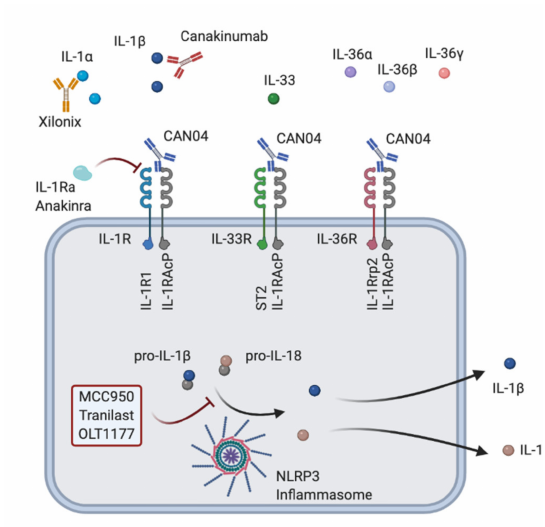
Figure 2. Different treatment strategies to modulate the IL-1–IL-1R pathway. Xilonix, anti-IL-1 α antibody; canakinumab, anti-IL-1 β antibody, IL-1Ra, IL-1 receptor antagonist; anakinra, recombi- nant IL-1 receptor antagonist; CAN04, anti-IL-1RAcP antibody; MCC950, inflammasome inhibitor; tranilast, inflammasome inhibitor; OLT1177, inflammasome